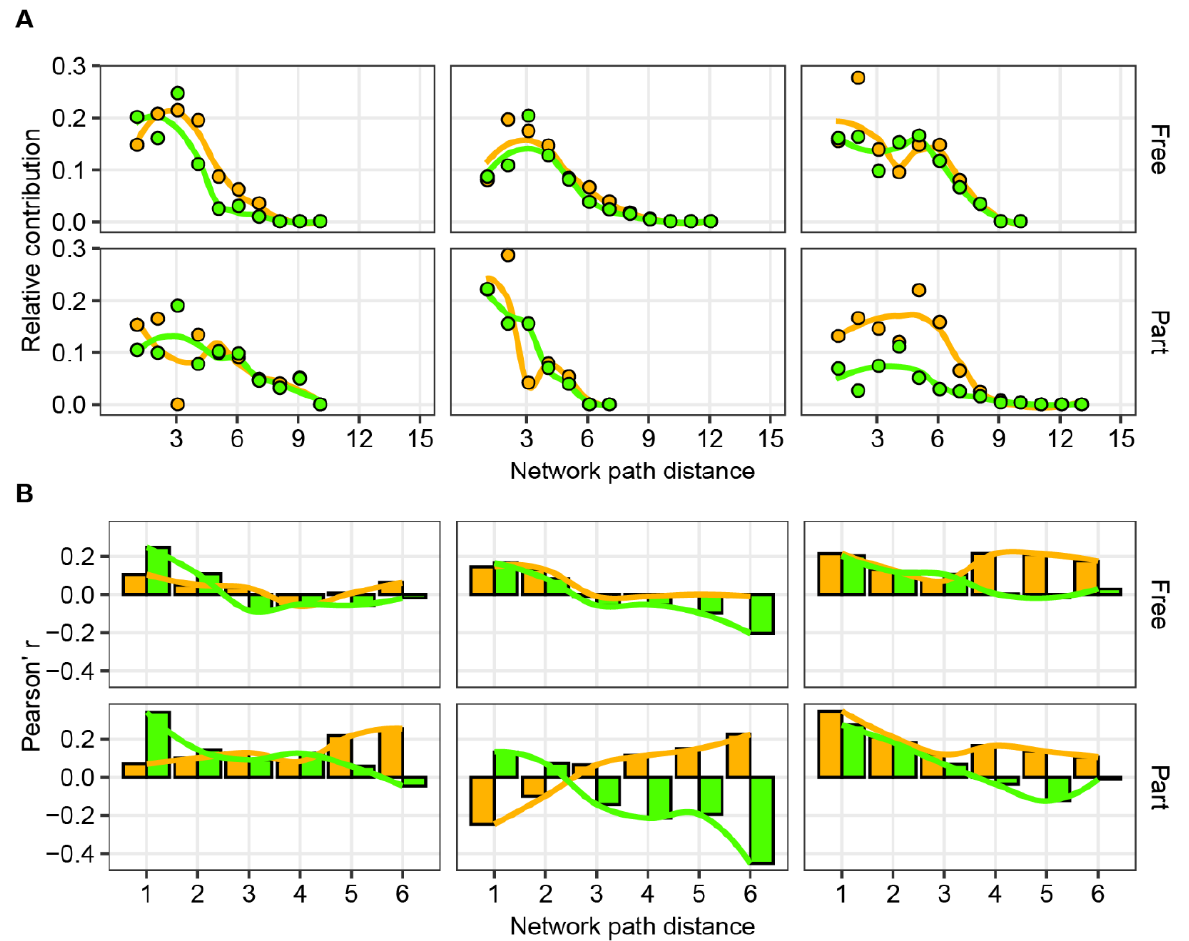
Figure 5. The contribution of species phylogeny and niche distance to their direct and indirect interactions. ( A ) The relative contribution of species phylogeny and niche distance to classifications of network path distance estimated by random forest classification analysis. The colors of points or lines vary with phylogeny (orange) and niche (green). The line is a Loess fit based on the points. ( B ) The Pearson’s correlations between species phylogeny or niche distance and network latent space distance ignore the potential for modularity across the network path distance. The colors of bars or lines vary with phylogeny (orange) and niche (green). The lines are a Loess fit based on the values of bars.